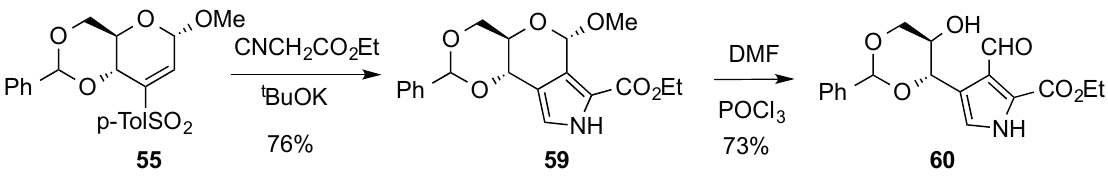
Figure 1. Vinyl-sulfone Michael acceptors 55 – 58 .